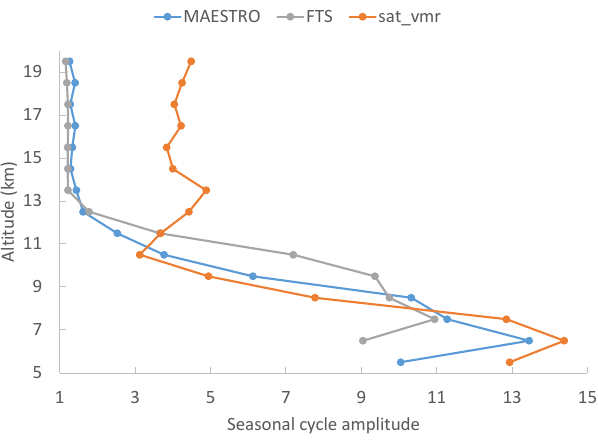
Figure 8. Vertical profile of response to AAO, using southern high- latitude water vapour relative anomalies based on monthly medi- ans (2004–2012). Horizontal bars are ± 1 σ , obtained by linear re- gression (including a trend term and/or a Cordón Caulle proxy term, depending on whether each is significant at the 1 σ level). The MAE_lat profile shows the MAESTRO water vapour response to AAO upon including a basis function to account for the non- uniform latitudinal sampling. The sat_vmr profile is obtained from a simple linear regression of saturation vapour VMR relative anoma- lies onto